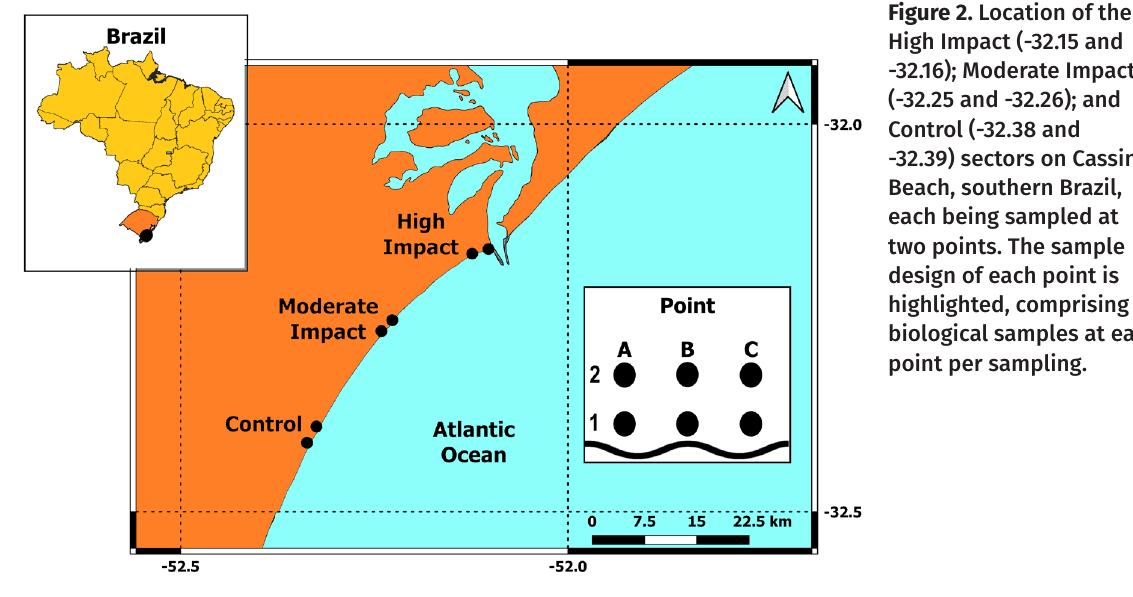
Figure 2. Location of the High Impact (-32.15